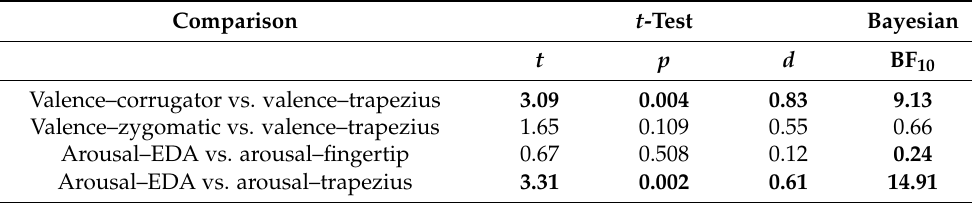
Table 2. Results of paired t -test and Bayesian paired t -tests of subjective–physiological